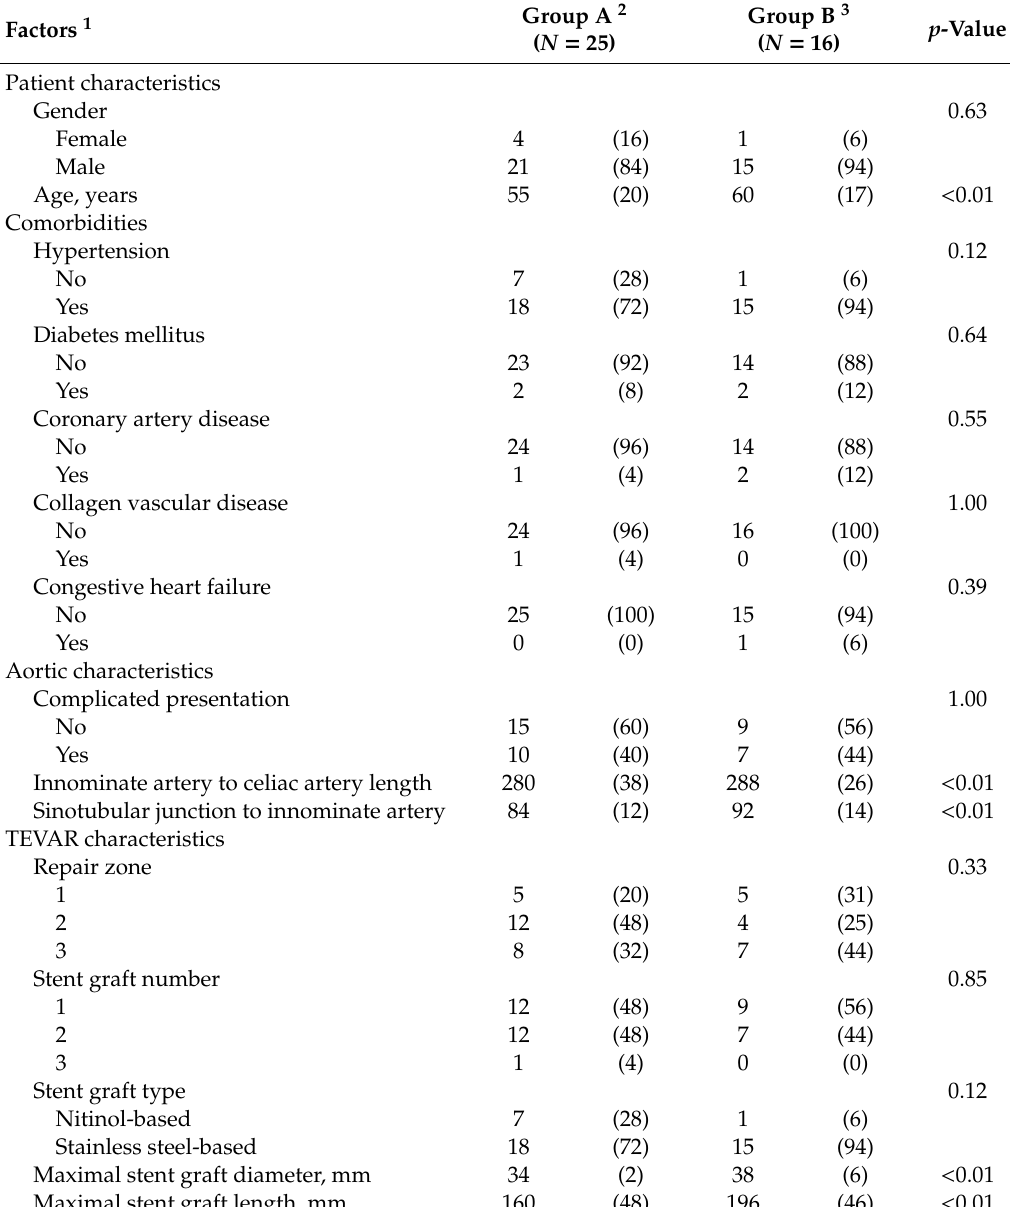
Table 5. Patient, aortic, procedural characteristics and